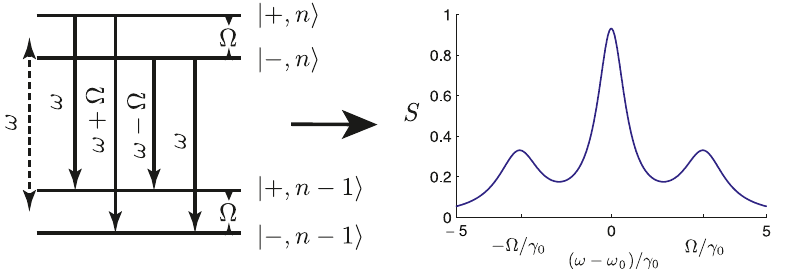
Figure 6. Energy level diagram of split levels of a two-level QE (“dressed” states) and resonance fluorescence spectra of a QE in a strong field in the absence of an NP ( Ω > γ 0 ) (Apanasevich–Mollow triplet). In this case, index n denotes the energy of the level expressed in photons of the field mode ω